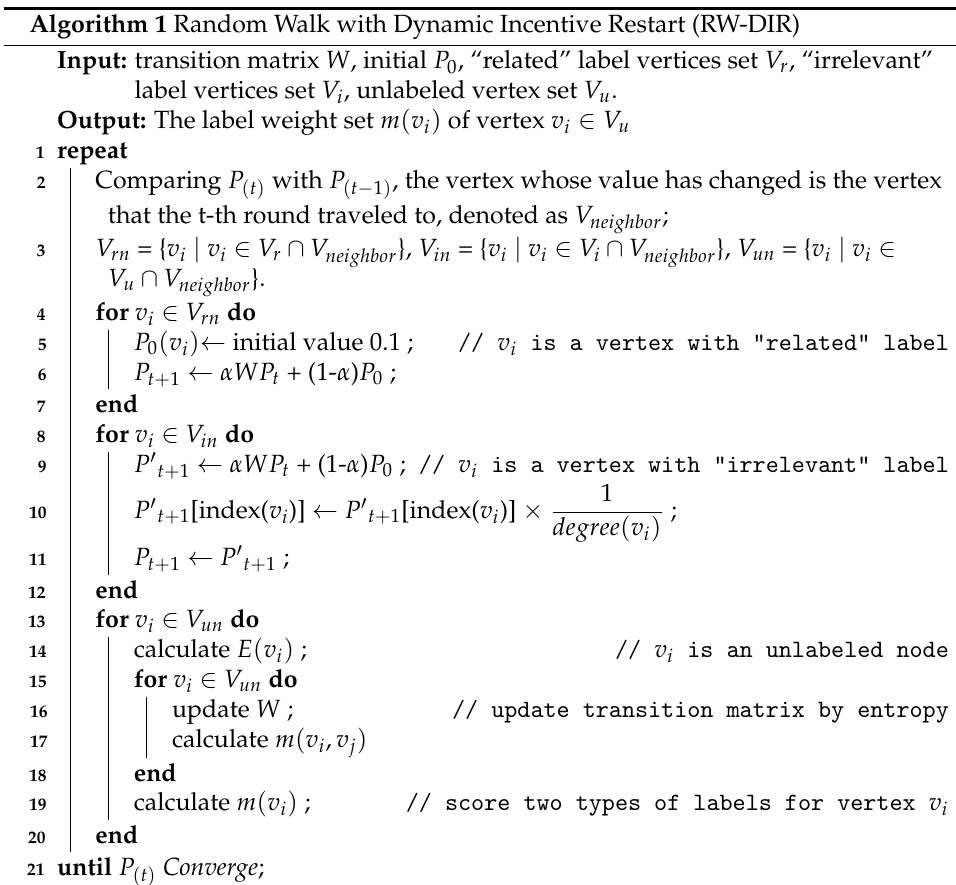
Algorithm 1 Random Walk with Dynamic Incentive Restart